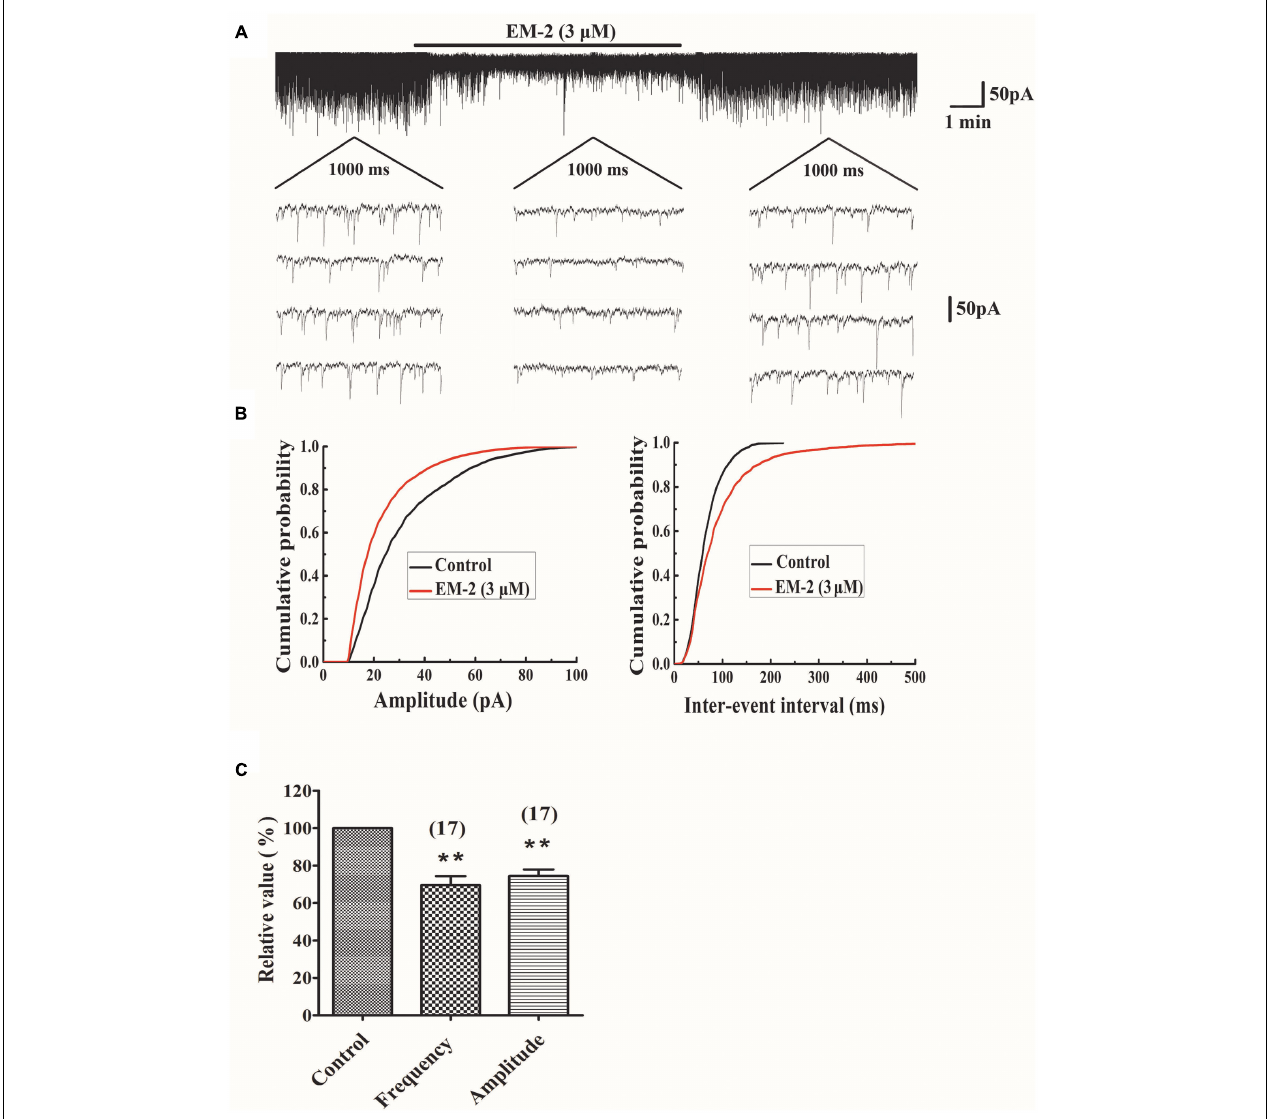
FIGURE 5 | EM-2 decreased amplitudes and frequencies of sEPSCs in TMR-DA labeled ventral horn motoneurons. (A) Sample traces of sEPSCs in the absence and presence of EM-2. In this and subsequent figures, the duration of drug superfusion is shown by a horizontal bar above the chart recording, and four consecutive traces of sEPSCs are shown in the expanded time scales. The period of each trace is 1,000 ms. (B) Cumulative distributions of the amplitudes (left) and inter-event intervals (right) of the sEPSC before (black line) and during (red line) the EM-2 applications. EM-2 significantly shifted the mean cumulative distribution of the sEPSC amplitude to lower amplitudes ( P < 0.01; Kolmogorov–Smirnov test) and significantly shifted the mean cumulative distribution of the sEPSC inter-event intervals to longer durations ( P < 0.01; Kolmogorov–Smirnov test). The data were obtained from the same neuron as in panel (A) . (C) Histogram showing that the sEPSC amplitude and frequency were significantly reduced by EM-2 ( P < 0.05, paired t -test n = 17). In this and the following figures, the numbers of neurons used to construct each data point are shown in parentheses. The vertical bars show the SDs. ∗∗ P < 0.01 versus control. Holding potential = –70